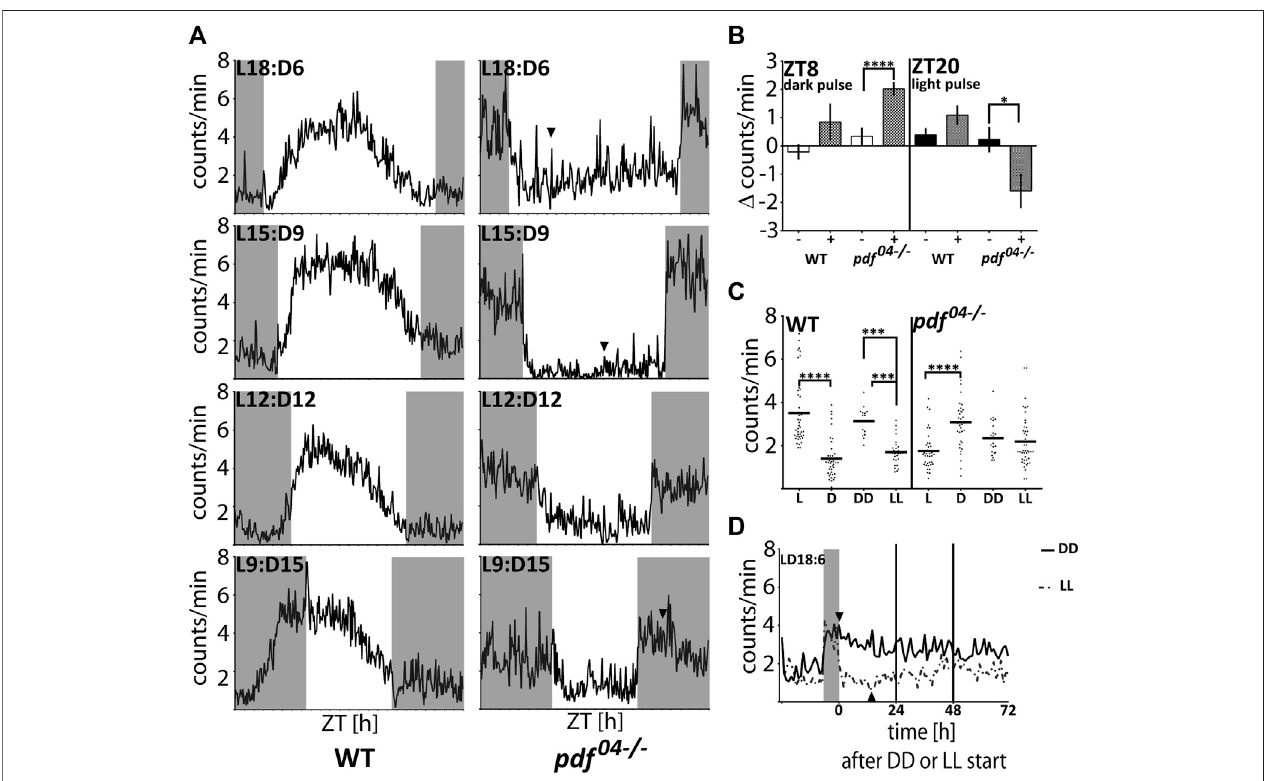
FIGURE 5 | The response of WT and pdf 04 − / − mutants to light and darkness. (A) The average locomotor activity of WT and pdf 04 − / − in different photoperiodic regimes. In pdf 04 − / − mutants in photoregimes L18:D6 and L15:D9, the activity during the light phase starts to increase several hours after the initial drop (arrowhead). In the photoregime L9:D15, the activity of pdf 04 − / − starts to fall several hours after the initial spike at the beginning of the night (arrowhead). Activity graphs represents the average activity ofall bugs scored as “ rhythmic in LD. ” Grey rectangles on graphsdepict darkness. (B) The effectof “ dark pulses ” applied at ZT8 and “ lightpulses ” applied at ZT20 on the average activity of WT ( n = 32, n = 35, respectively) and pdf 04 − / − mutants males ( n = 59, n = 39, respectively). (C) Average activity of WT and pdf 04 − / − during the light(L) and darkness (D) in LD18:6 cycles, constant darkness (DD) and constant light (LL). Every dot representsa measurementfrom asingle individual. InLDcyclestheactivityduringthelightordarknesswasaveragedforthreelastdays.InDDandLLactivitywasaveragedfromthetotalnumberofminutesduring10 days of measurement. The horizontal bar represents mean. Statistical differences are marked by (***) p < 0.001,(****) p < 0.0001. (D) The average activity of pdf 04 − / − mutants on the last day in LD 18:6 and three following days in constant darkness (DD - solid line) or constant light (LL-dashed line). The level of the activity becomes